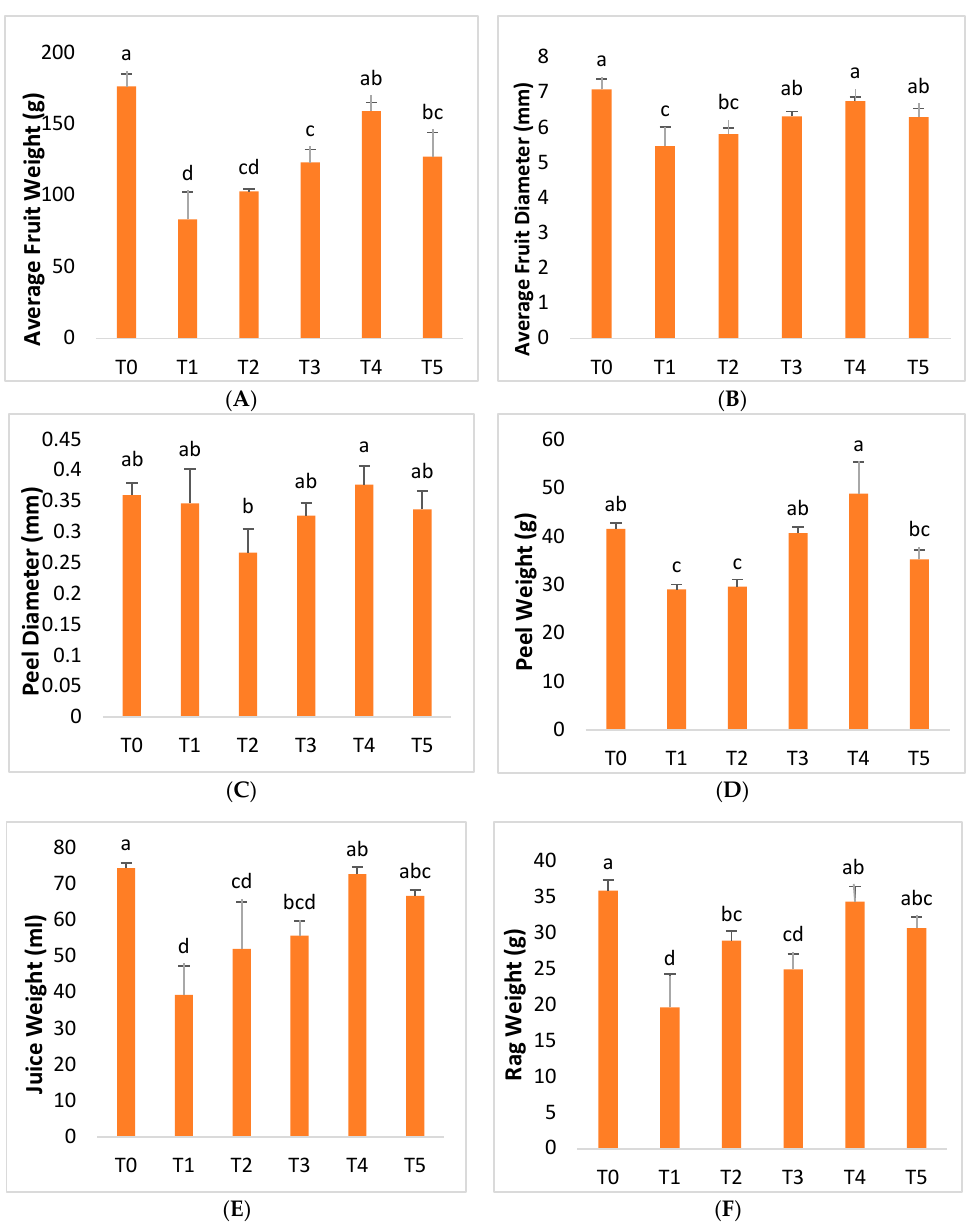
Figure 8. Differential effects of treatments of AgNPs on ( A ) average fruit weight, ( B ) average fruit diameter, ( C ) peel diameter, ( D ) peel weight, ( E ) juice weight, and ( F ) rag weight.